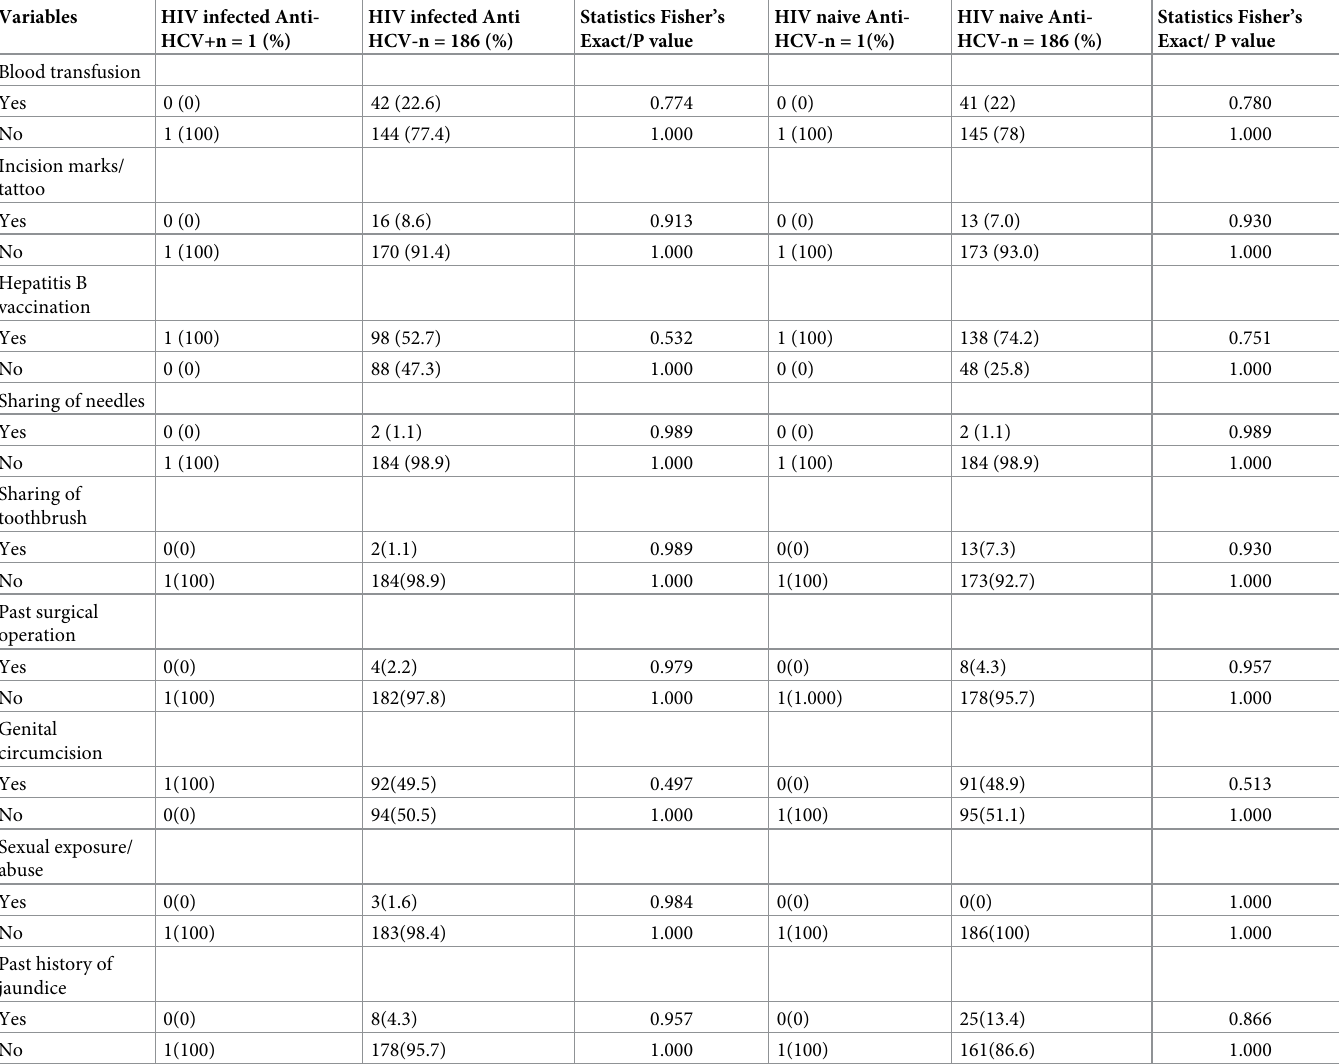
Table 4. Comparison of the risk factors for HCV acquisition among HIV infected and HIV naive